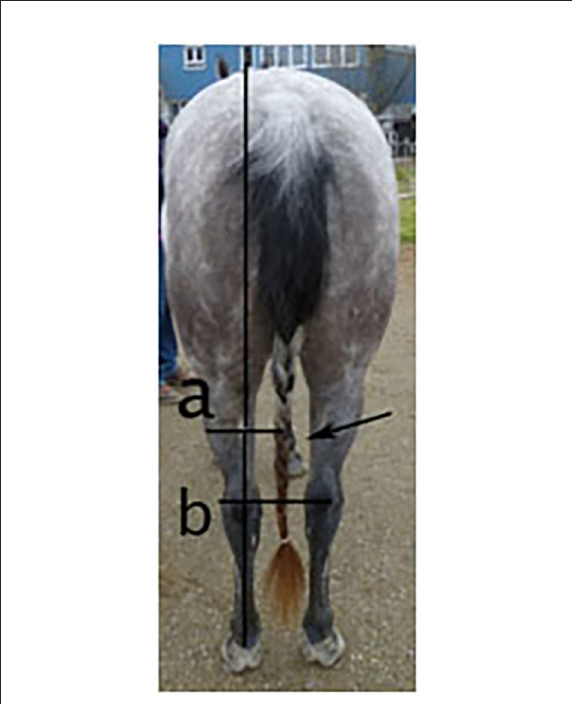
FIGURE1 Lateral displacement of the hindquarters to the right with the right forelimb visible between the hind limbs (arrow). Line b shows the position of the hind limbs (hocks). Line a indicates the position of the front limbs (fetlocks). The vertical reference line shows the position of the front fetlocks in relation to the hocks.